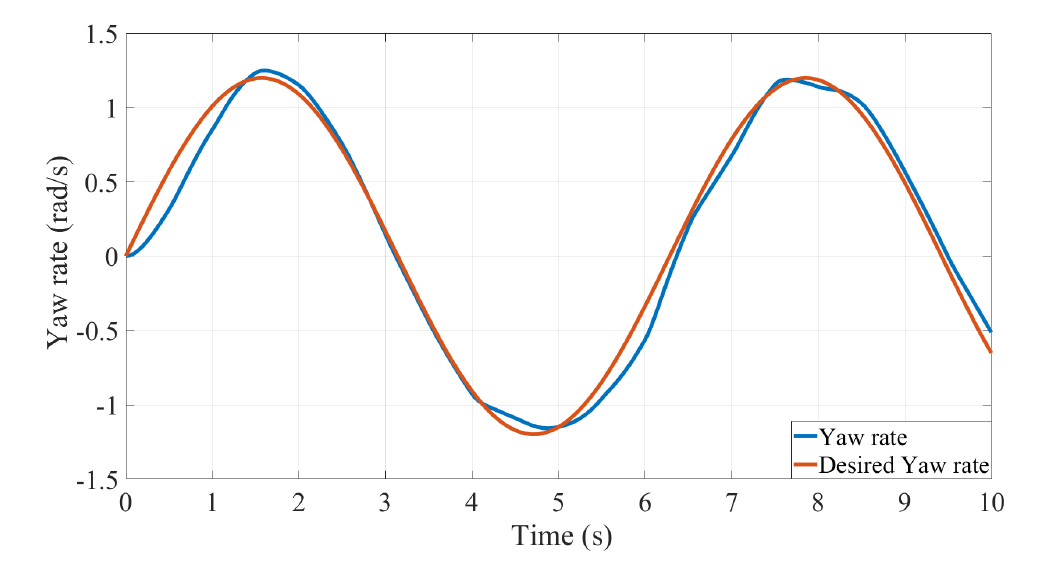
Figure 10. Uncontrolled yaw rates with disturbance with sine wave input.